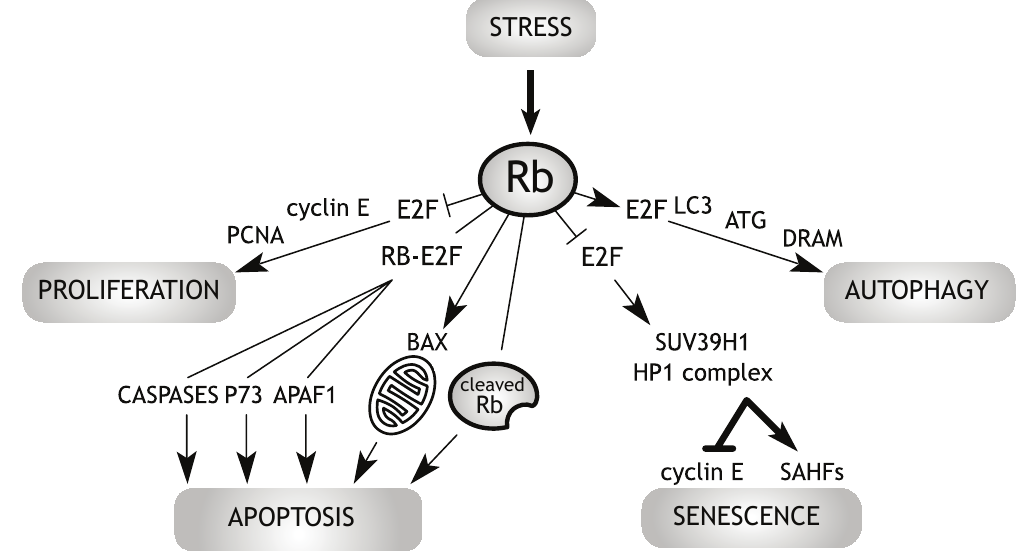
Figure 3 - RB pathways in proliferation, apoptosis, autophagy and